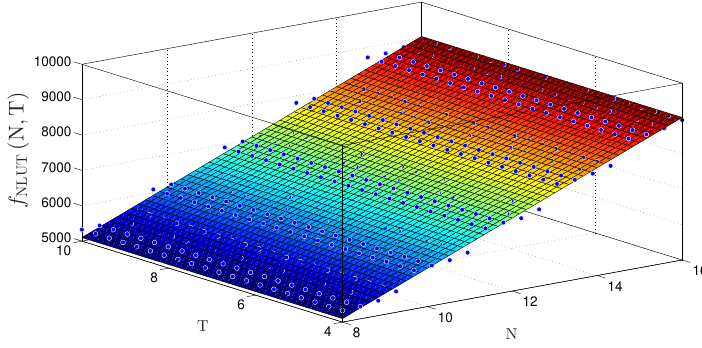
Figure 16. Plane, f NLUT ( N,T ) , found to estimate the number of LUTs as a function of the number of bits N and T for TS-FIMM-P.